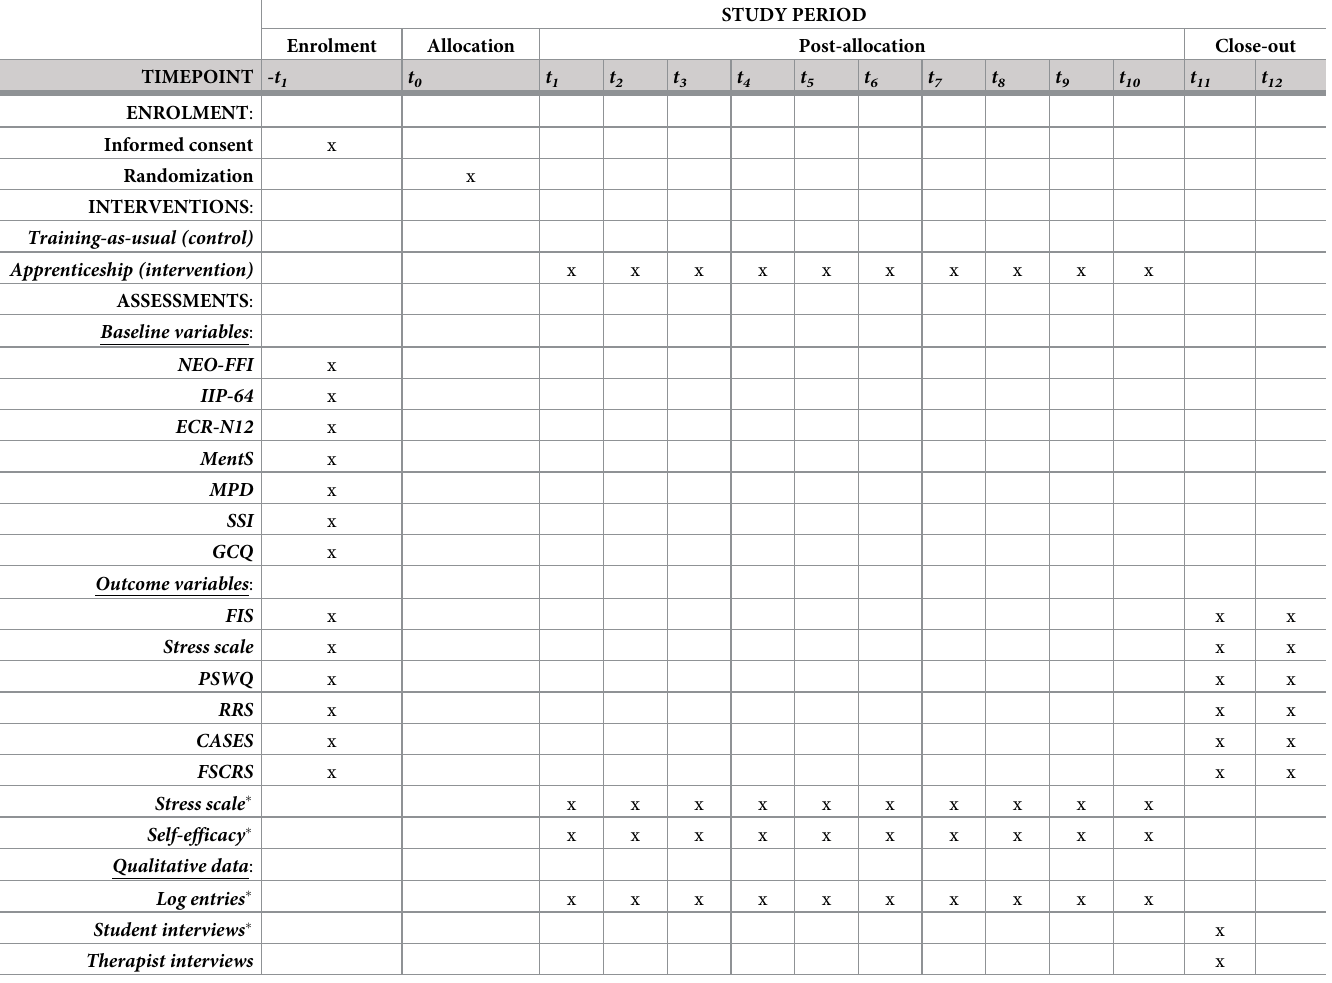
psychology students trained in the FIS methodology and blind to treatment condition and time of assessment.